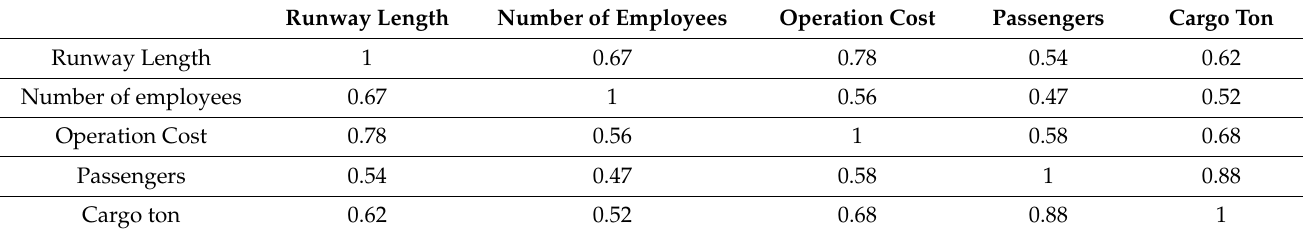
Table 1. Correlations among variables. Source: Authors’ own